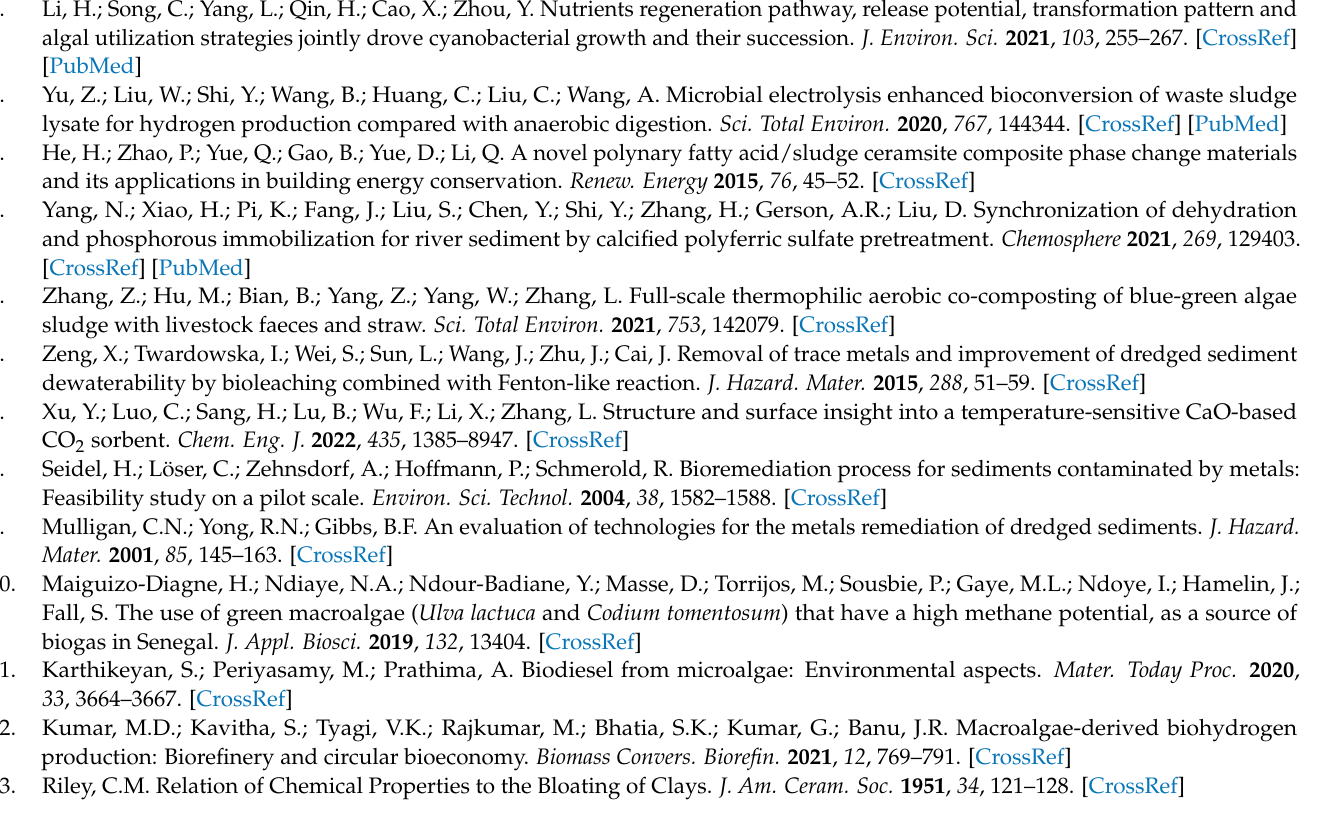
Table S1: Analyze data; Table S2: Analyze